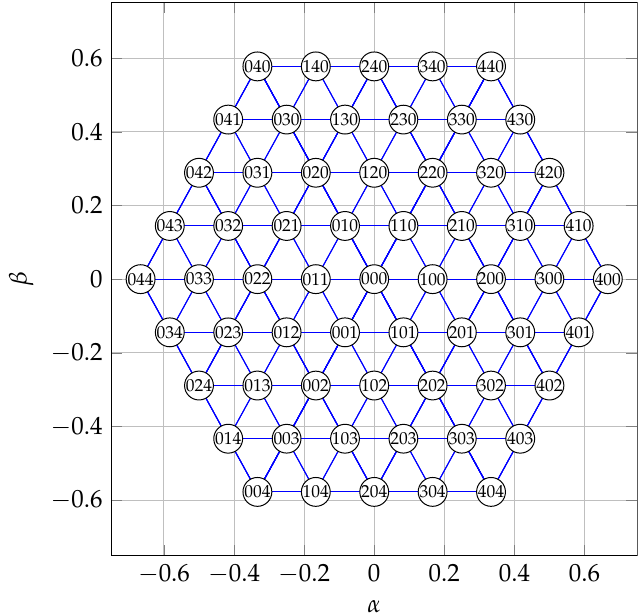
Figure 3. Normalized voltage hexagon (with respect to u dc ) of a 5-level